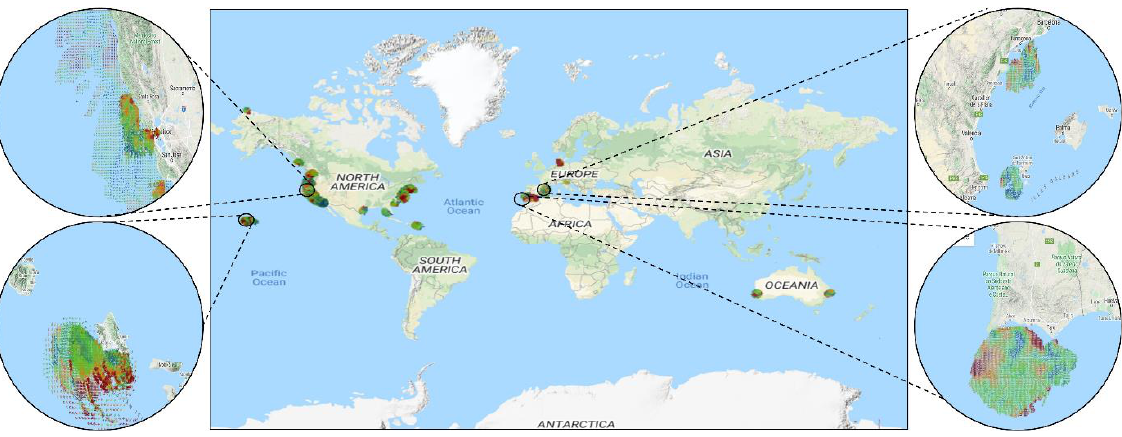
Figure 5. The locations of the global HF radar network.